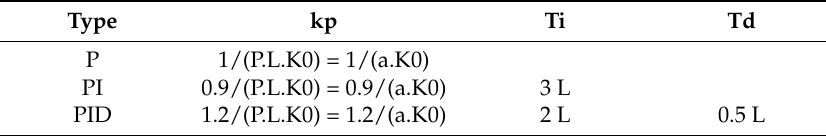
Table 3. Parameters of the PID (proportional-integral-derivative)